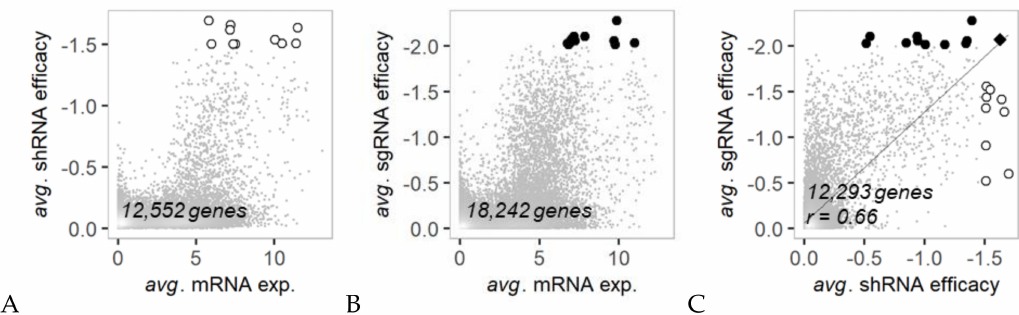
Figure 1. Distribution of genes by average mRNA expression vs. average RNAi e ffi cacy in colon cancer cell lines. ( A ) Average mRNA expression and average shRNA e ffi cacy were calculated and compared using 42 colon cancer cell lines. Empty circles represent the top 10 genes with the highest shRNA knockdown e ffi cacy ( < − 1.5). ( B ) Average mRNA expression and average sgRNA e ffi cacy were calculated and compared using 35 colon cancer cell lines. Filled circles represent the top 11 genes for which the sgRNA knockout e ffi cacy was highest ( < − 2). ( C ) Average shRNA e ffi cacy and average sgRNA e ffi cacy were compared for 12,293 genes. A common hit gene from ( A , B ) is represented by a rhombus shape. The list of 20 hit genes can be found in Table S1.